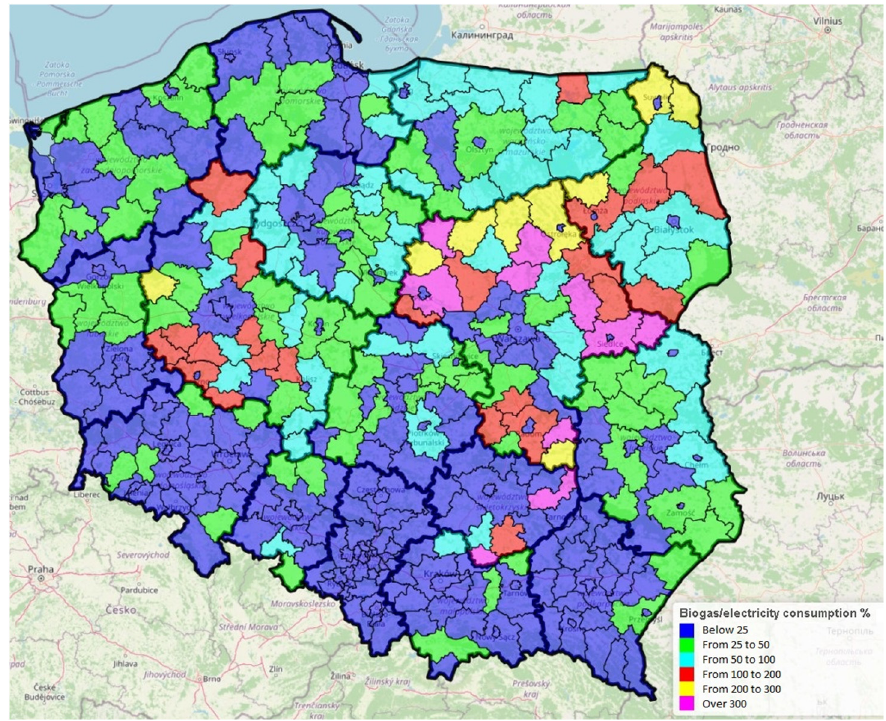
Figure 8. Electricity consumption coverage through the potential of biogas electricity generation in 2020.